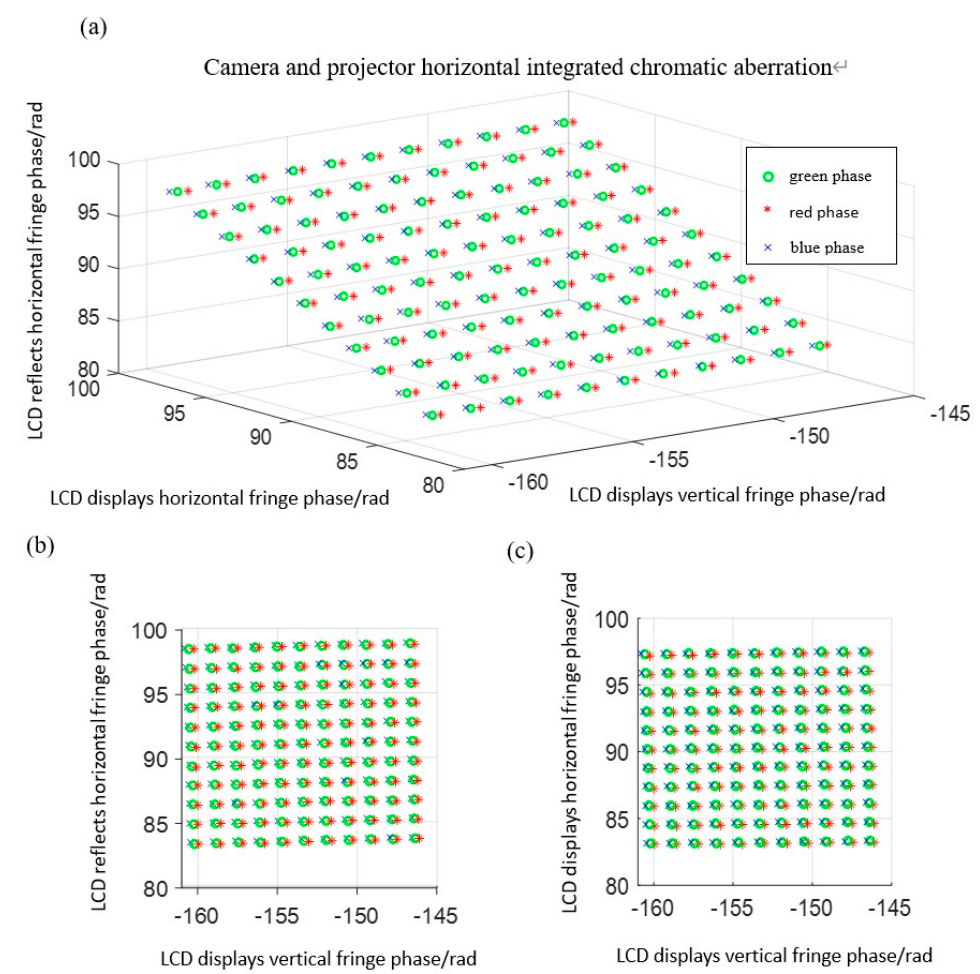
Figure 9. Comprehensive chromatic aberration of the camera and projector in the horizontal direction: ( a ) three − dimensional coordinate system diagram; ( b ) front view; ( c ) top view.